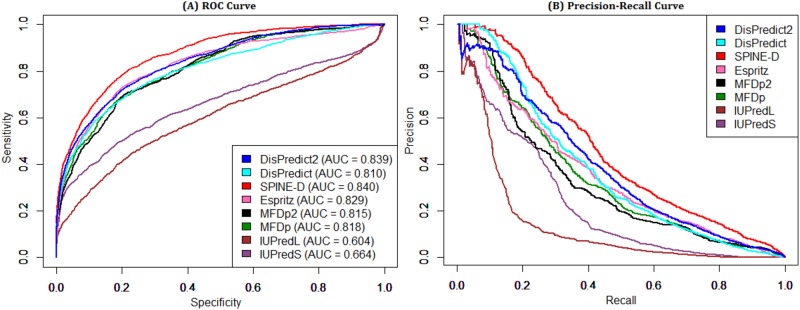
ROC and precision-recall curves given by 8 disorder predictors for CASP10 dataset.Comparison of disorder predictors in terms of (A) ROC curve and (B) precision-recall curve on CASP10 dataset. The area under ROC curves are given in the plot (A).